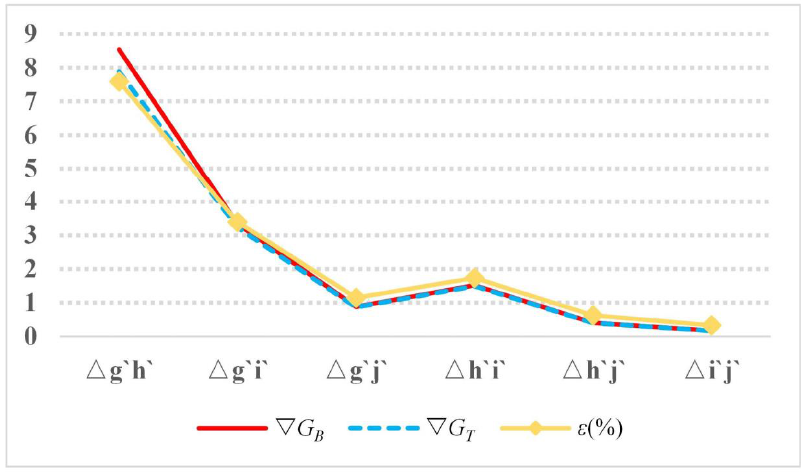
Figure 10.  G of matrix transposition schemes under the condition of d`. Figure 10. ∇ G of matrix transposition schemes under the condition of d‘ .